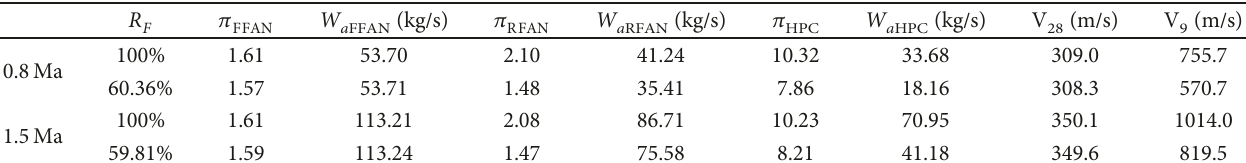
Figure 14: Control schedule of variable geometries (11 km, 1.5Ma). Table 9: Important performance parameters during throttling.